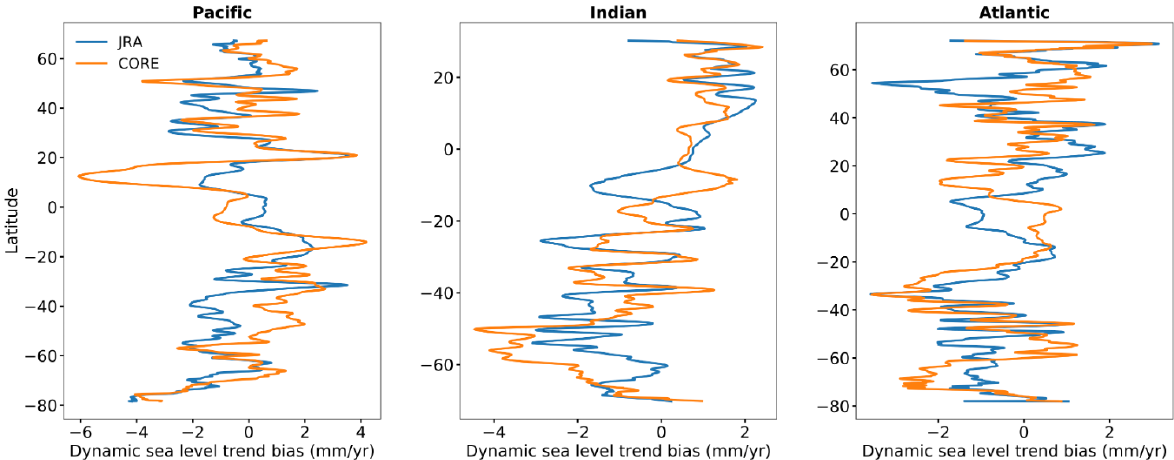
Figure 15. The zonal mean DSL trend bias at all three major basins from JRA55-do (blue) and CORE (orange) forced simulations during